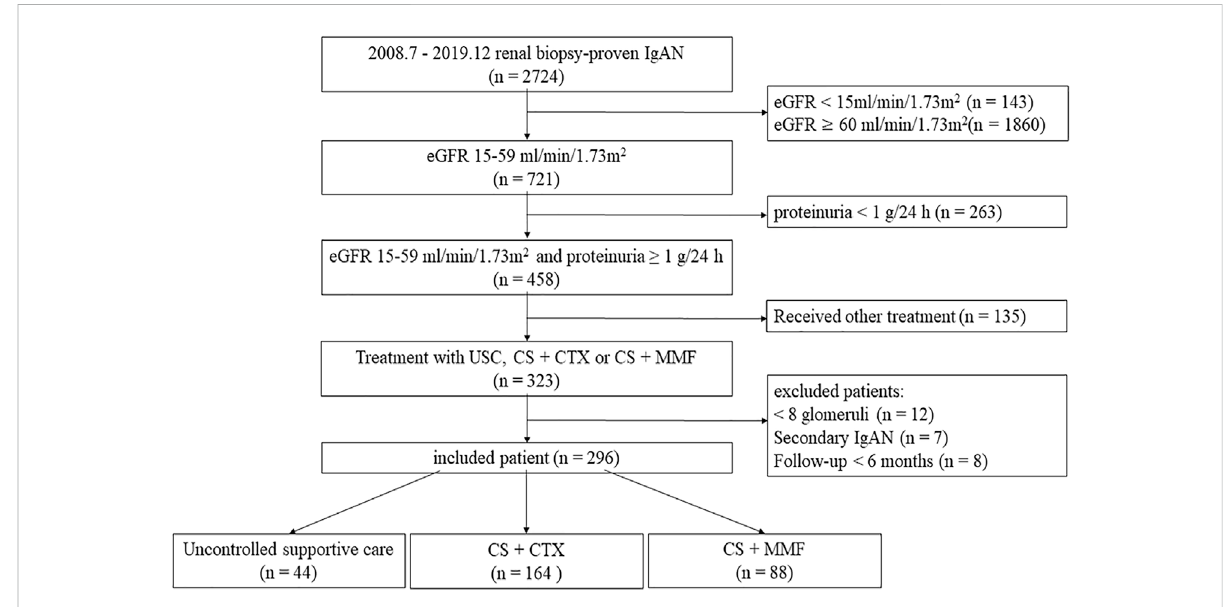
FIGURE 1 Inclusion fl owchart. eGFR, estimated glomerular fi ltration rate; UCS, uncontrolled supportive care; CS, corticosteroids; CTX, cyclophosphamide; MMF, mycophenolate